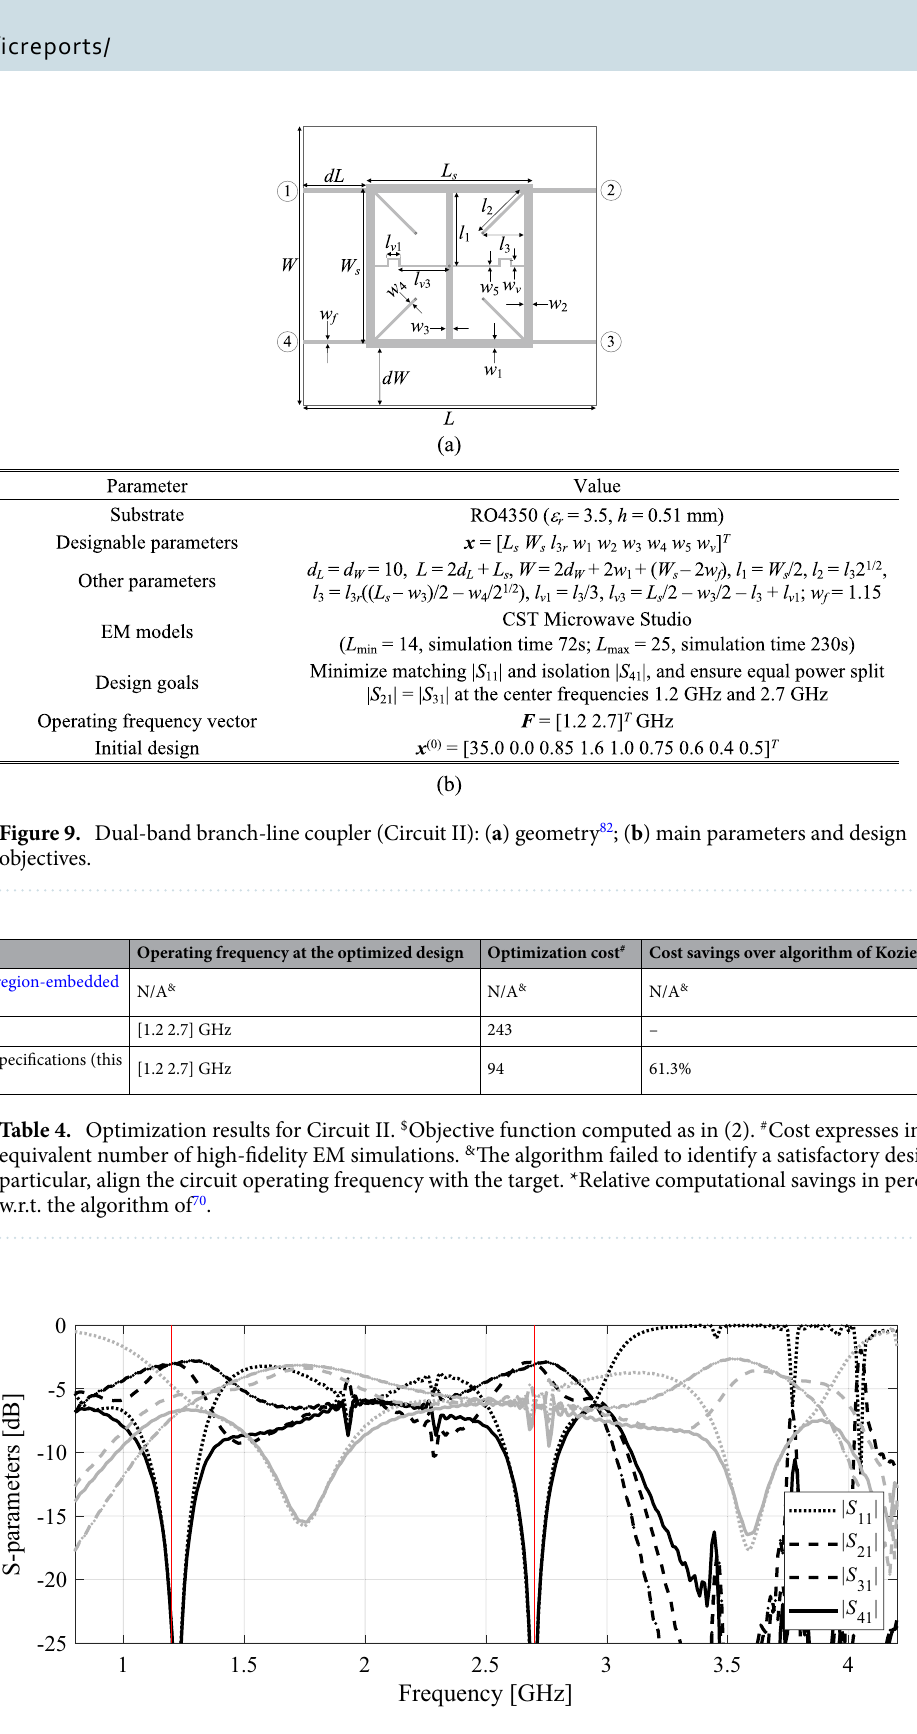
Figure 10. Dual-band branch-line coupler: circuit responses at the initial design (grey lines), and the optimal design rendered by the introduced framework with design specification adaptation and variable-fidelity models (black lines). Vertical lines mark target operating